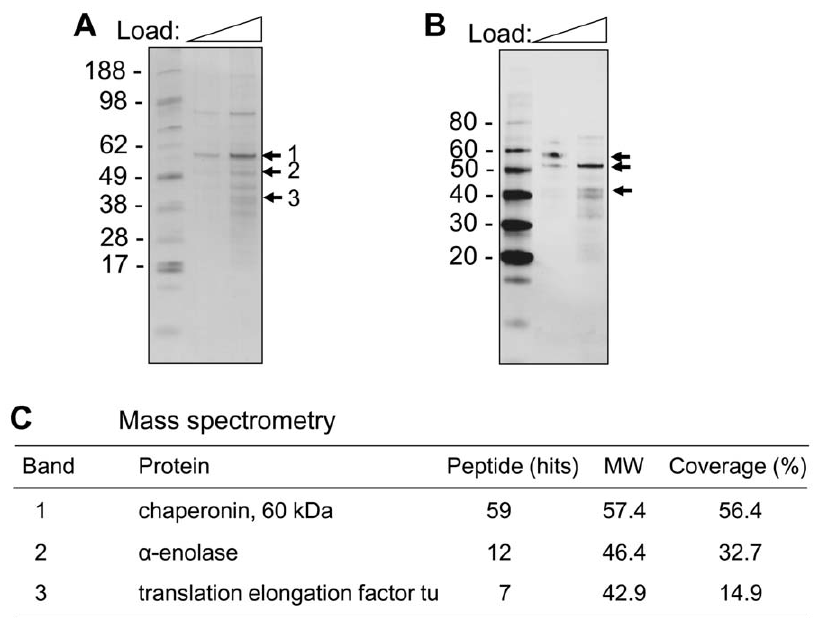
Figure 4. Identification of PLG receptors. Spore extracts obtained from an acidic buffer were separated on a 4–12% SDS-PAGE. (A) The proteins were visualized by coomassie brilliant blue staining (CBB). (B) Far-Western (Ligand) blot with PLG. The proteins were transferred onto a nitrocellulose membrane, and the membrane was incubated with PLG. PLG-bound proteins were visualized by Western blotting with anti-PLG antibody. (C) Identification of proteins interacting with PLG. Bands (1–3) were excised from the gel and subjected to in-gel digestion with trypsin. LTQ-MS/MS was performed to identify the proteins.